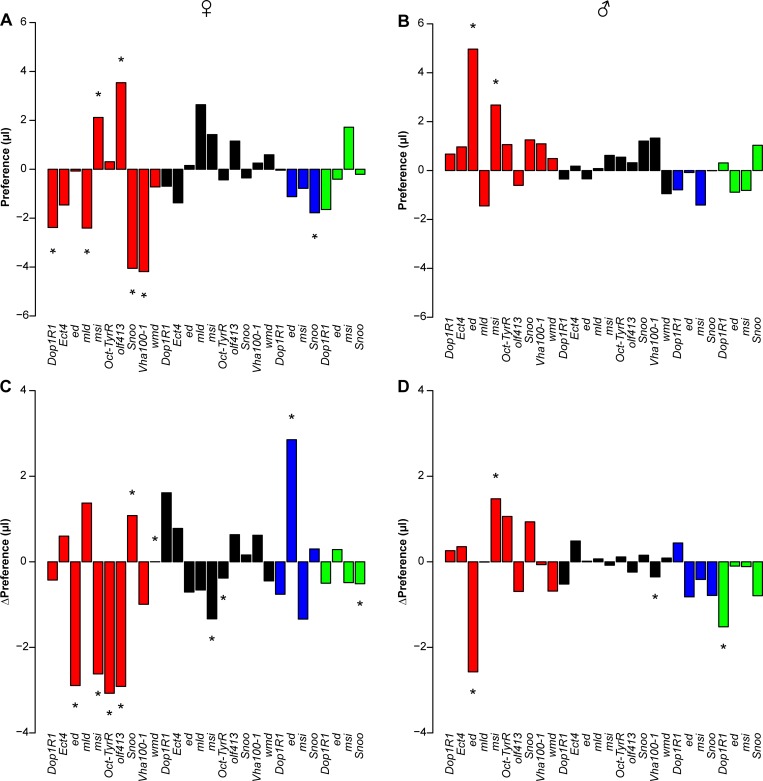
Differences in methamphetamine preference and change in methamphetamine preference between the third and first exposures between RNAi and control genotypes.(A) Female Preference A. (B) Male Preference A. (C) Female change of Preference A. (D) Male change of Preference A. Red, black, blue, and green bars denote elav-GAL4, repo-GAL4, 201Y-GAL4 and TH-GAL4 drivers, respectively. Asterisks represent significant L×S terms (A, B) or significant L×S×E terms from the full ANOVA models. Exact P-values are given in S11 Table.